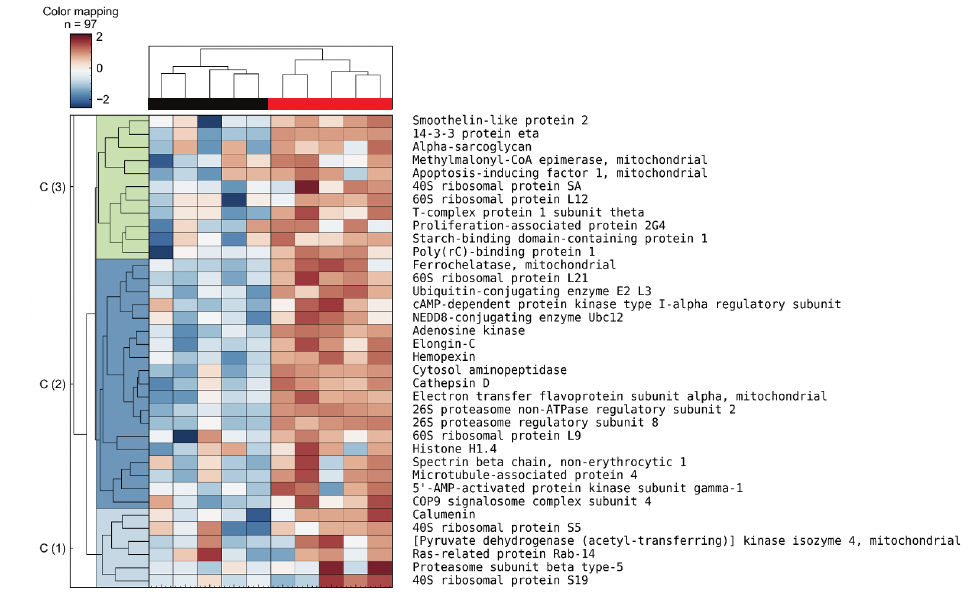
Figure 2. Remodelling of skeletal muscle proteome in 8-week-old th 3/+ mice. ( A – D ) Unsupervised